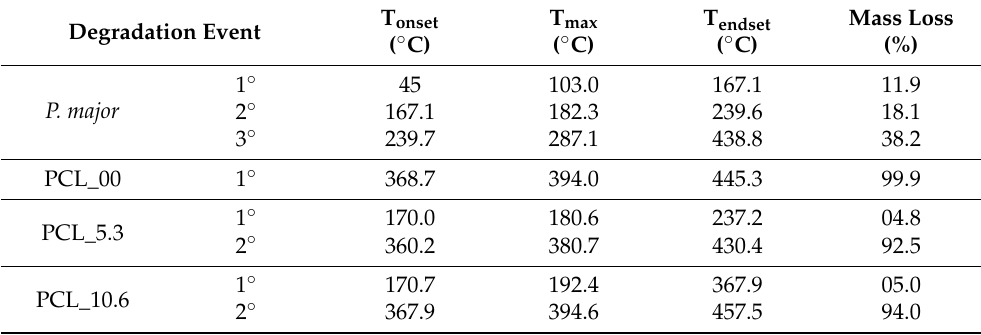
Table 2. Thermal characteristics (TGA) of electrospun mats of P. major , and PCL with different compositions of extract.